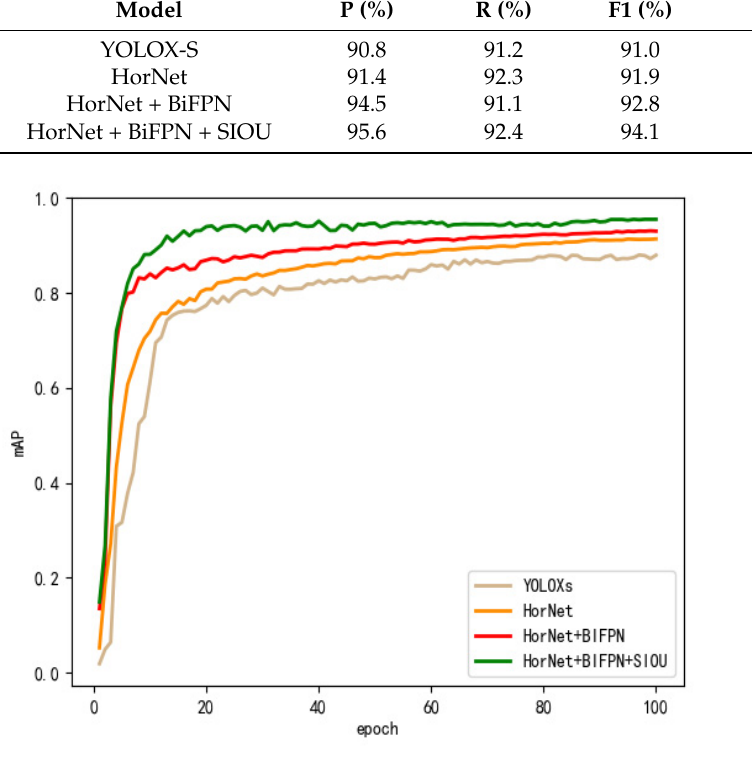
Figure 4. mAP curves of different improvement methods